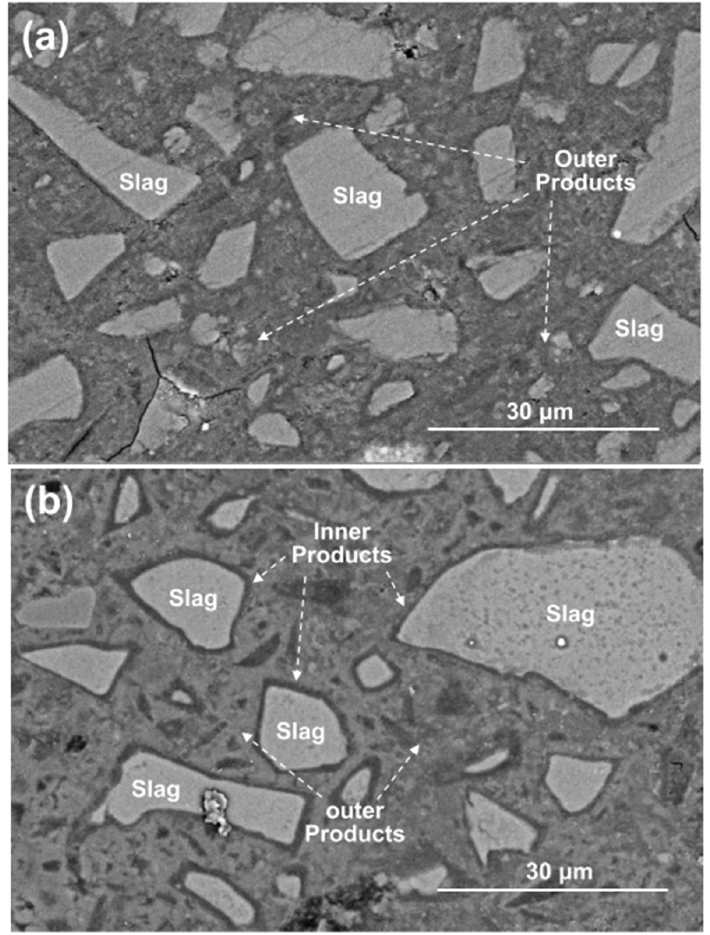
Figure 11. BSE images of the 28 days cured ( a ) C1M4 and ( b ) C4M1 samples. Based on the phase assemblage and microstructure evolution results discussed above, the acceleration mechanism in the Na 2 CO 3 -activated slag binders modified with the combined auxiliary activators (Ca(OH) 2 and Mg(OH) 2 ) is proposed here. The Mg 2+ ions released from Mg(OH) 2 react with the Al 3+ ions dissolved from slag to form the hy- drotalcite-like phase, which has the Mg-Al double layered structure and works as the car- bonate binding agent in the binder to increase the alkalinity [25]. When compared with Mg(OH) 2 , Ca(OH) 2 is more effective in accelerating the reaction kinetics. Due to the higher solubility of Ca(OH) 2 , more OH - ions are released in the paste to yield a significant in- crease in the pH, resulting in a further dissolution of slag. More Ca 2+ ions released from Ca(OH) 2 are able to promote the formation of the main binding C-A-S-H gel in the binder. The formation of a compact pore structure not only enhances the compressive strengths, but also mitigates the drying shrinkage of the binders. 4. Conclusions In this work, the combined auxiliary activators of Ca(OH) 2 and Mg(OH) 2 were incor- porated in the Na 2 CO 3 -activated slag binders to promote hardening and accelerate the early-age strength development at the ambient temperature. The setting times, compres- sive strengths, and autogenous and drying shrinkage were evaluated, and the phase as- semblage and microstructure evolution were characterized via a variety of methods. The main conclusions are listed as follows.